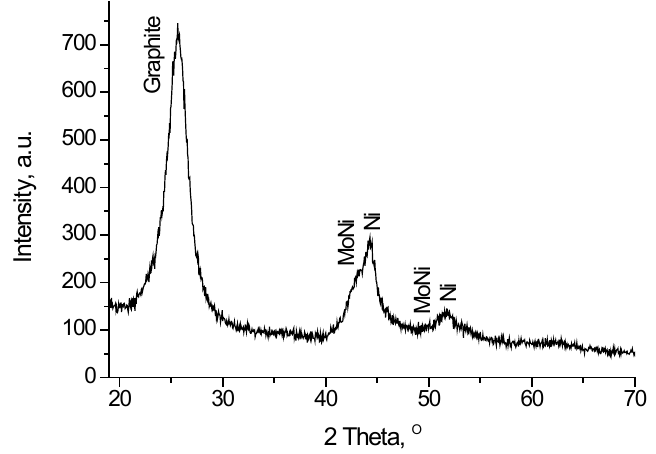
Figure 2. XRD pattern of 8% Ni-2.5% Mo/Sibunit.